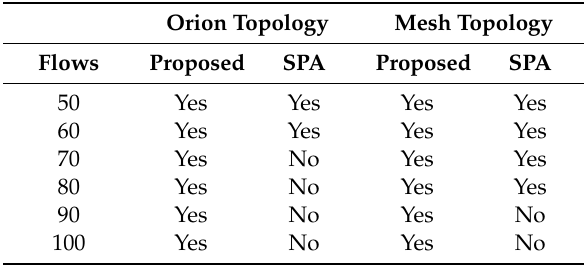
Table 3. Results of schedulability